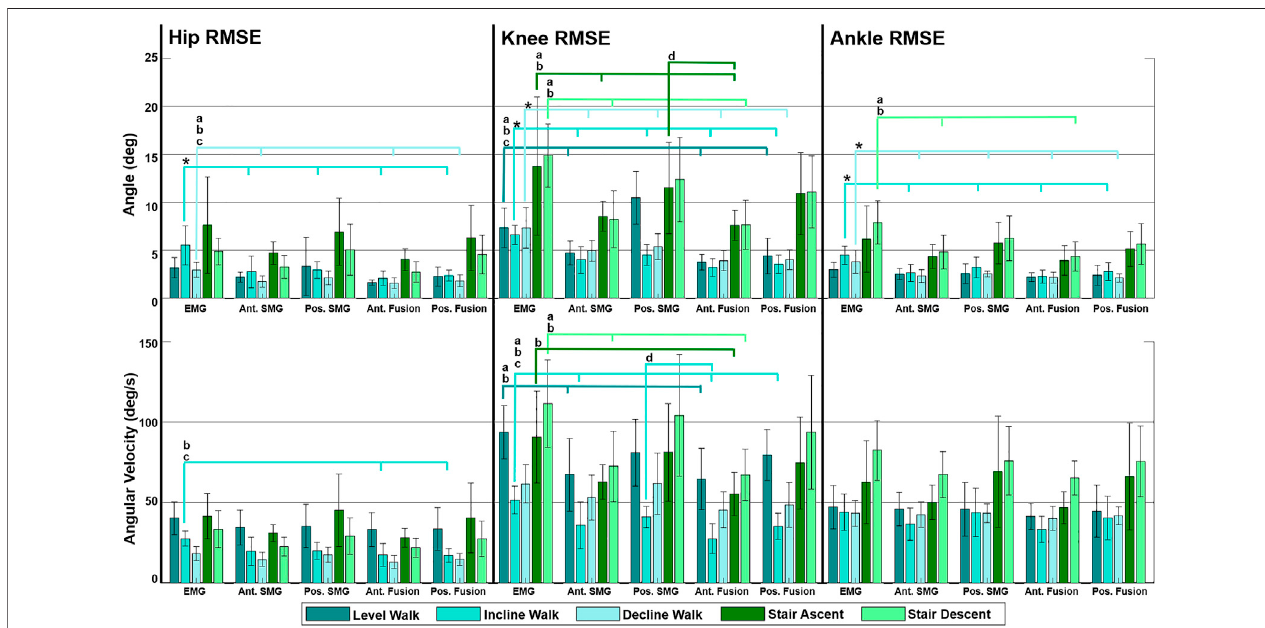
FIGURE3| Meanofallsubjects( N =9)rootmeansquareerror(RMSE)ofhip,kneeandankleangleandangularvelocitypredictedbyGaussianprocessregression models trained by multiple feature sets during fi ve ambulation tasks. Feature sets include surface electromyography (EMG), anterior sonomyography (Ant. SMG), posteriorsonomyography(Pos.SMG),Ant.SMGsensorfusion(Ant.Fusion),andPos.SMGsensorfusion(Pos.Fusion).RMSEswerecalculatedbetweensensor-based prediction of joint kinematics and estimated kinematics. Error bars display standard deviations for the respective RMSE. Signi fi cance bars indicate signi fi cant difference ( p < 0.05) between RMSE of (*) EMG and all other sensing modalities, (a) EMG and anterior SMG, (b) EMG and anterior sensor fusion, (c) EMG and posterior sensor fusion (posterior SMG with EMG), and (d) posterior SMG and anterior sensor fusion (anterior SMG with